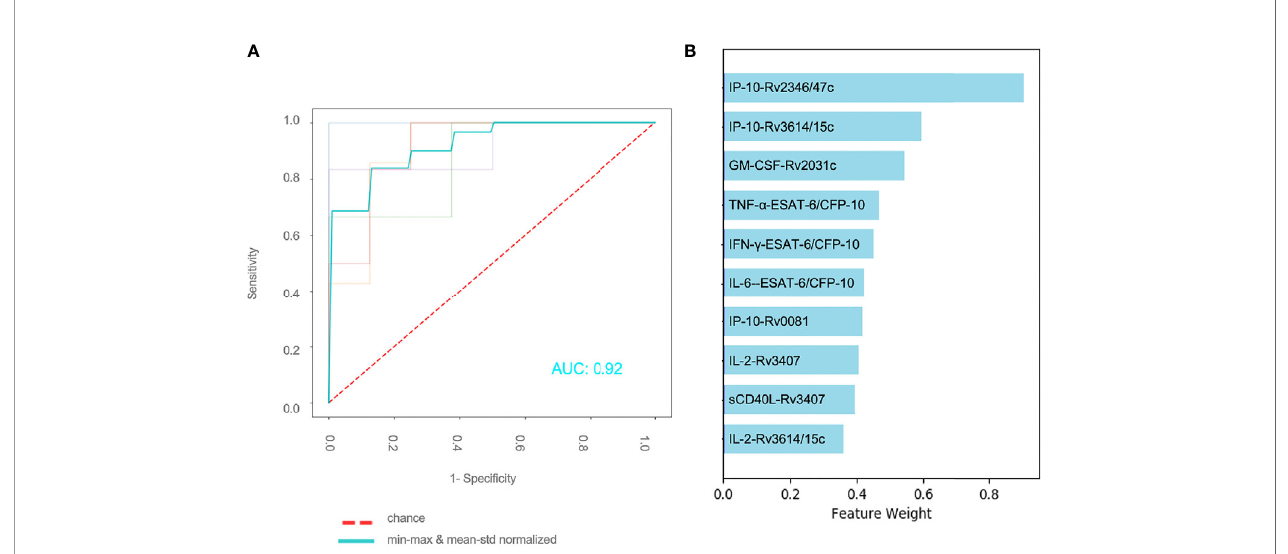
FIGURE 3 | Effect of normalization of antigen – cytokine pairs and normalization for individual patients (A) Performance of binary classi fi er using the 10 most important features and applying an antigen – cytokine pair normalization (min – max) and a normalization for individual patients (mean – std) (B) Combination of 10 antigen – cytokine pairs contributing the most to performance of trained discriminative classi fi er with min – max normalization of antigen – cytokine pairs and mean – std individual patient